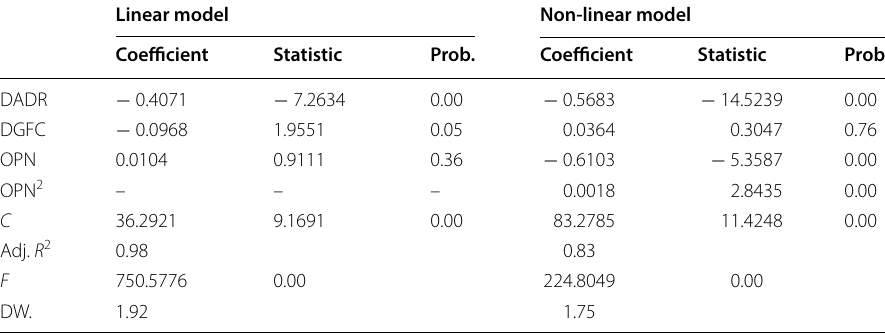
Table 5 Resulted coefficients and statistics of Model 2-L and Model 2-N